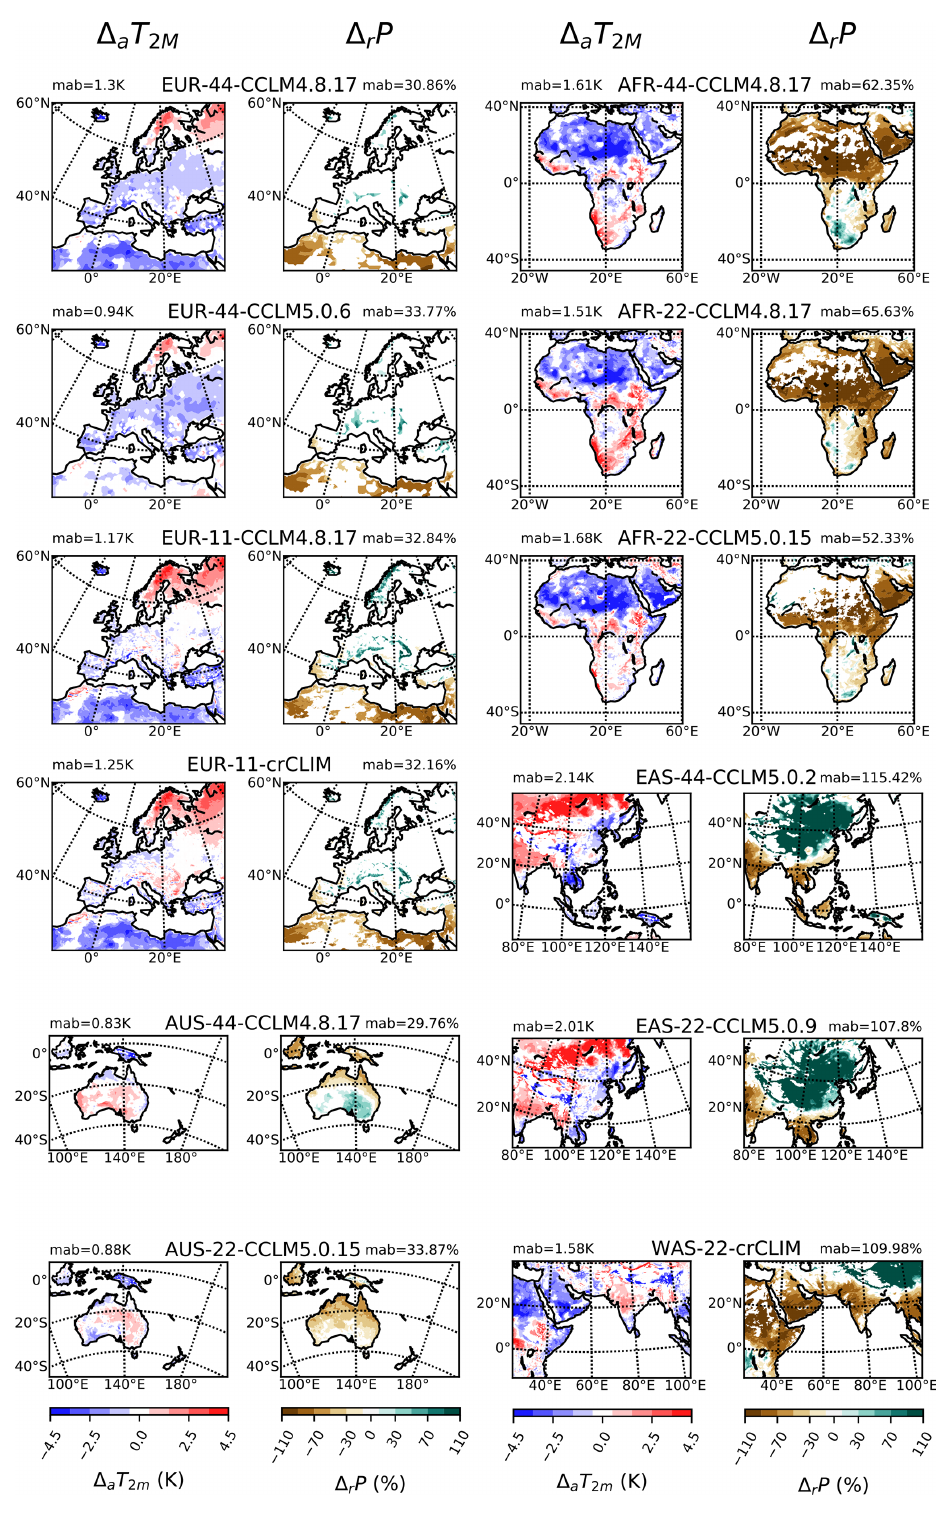
Figure 3. Same as Fig. 2 but for